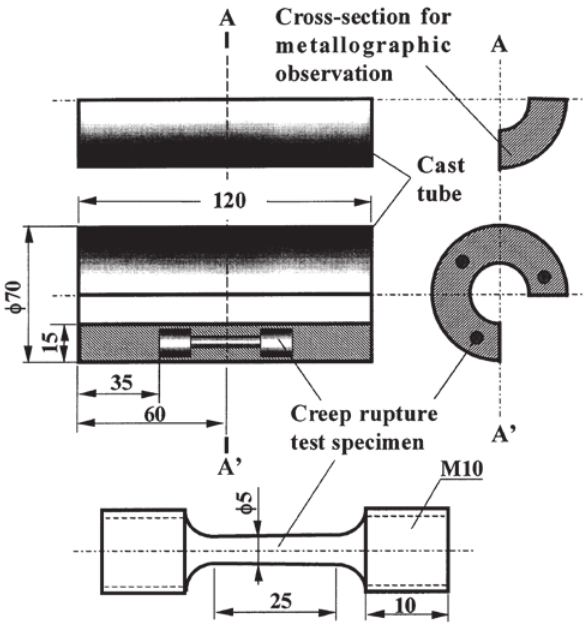
Fig. 2: Sampling diagram and the sizes of the creep rupture test specimens [12].